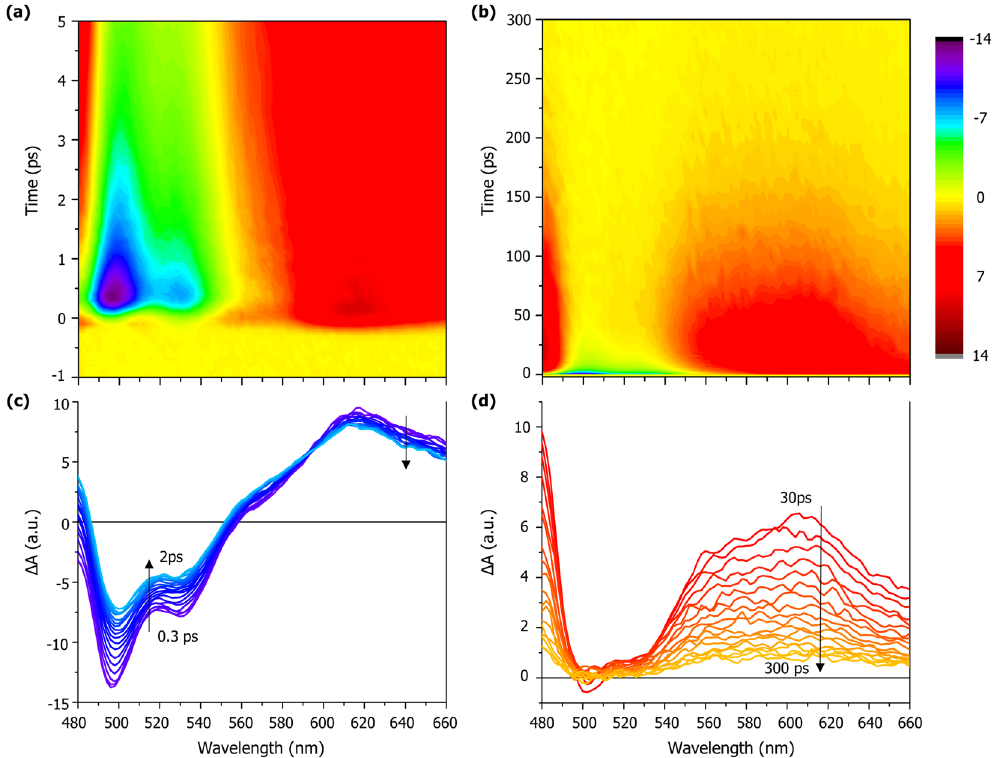
Figure 3. Transient absorption spectrum of QPH in cyclohexane (100 μ M). ( a ) and ( b ) show 3D plots in different time scales, whose spectral evolution is shown in ( c ) from 0.3 to 2 ps and ( d ) from 30 to 300 ps.